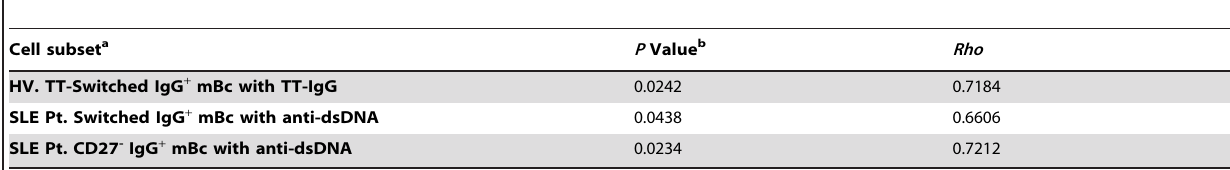
Table 2. Memory B cell subsets that correlate with antigen-specific immunoglobulins or autoantibodies.